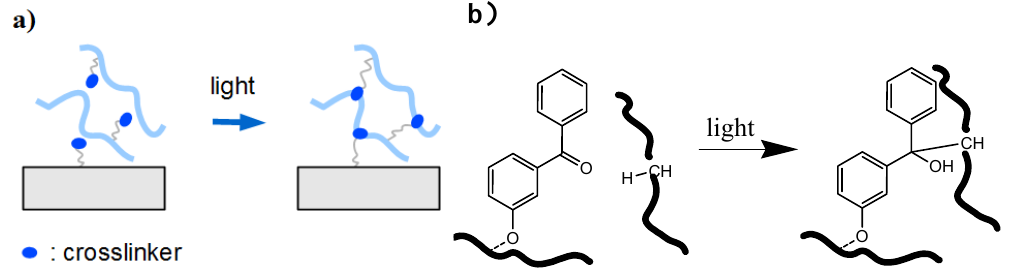
Figure 4. ( a ) Schematic representation of an insertion process involving only one photoreactive molecule. ( b ) Example of a photoinduced C-H insertion with one benzophenone